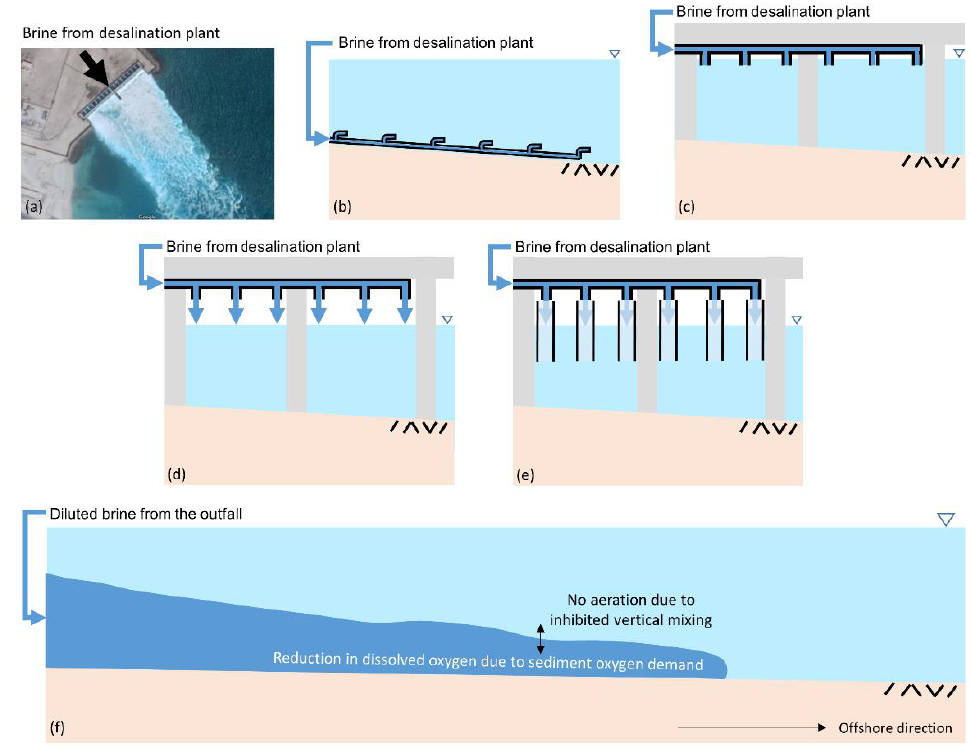
Figure 1. Different types of outfalls for the discharge of brine: ( a ) Surface discharge, ( b ) momentum dominated submerged multiport discharge, ( c ) buoyancy dominated surface multiport discharge, ( d ) unconfined plunging jets, and ( e ) confined plunging jets. Diluted brine from any of these outfalls can spread along the seafloor and result in a thin layer with low dissolved oxygen ( f ). (Figure modified from [10].)